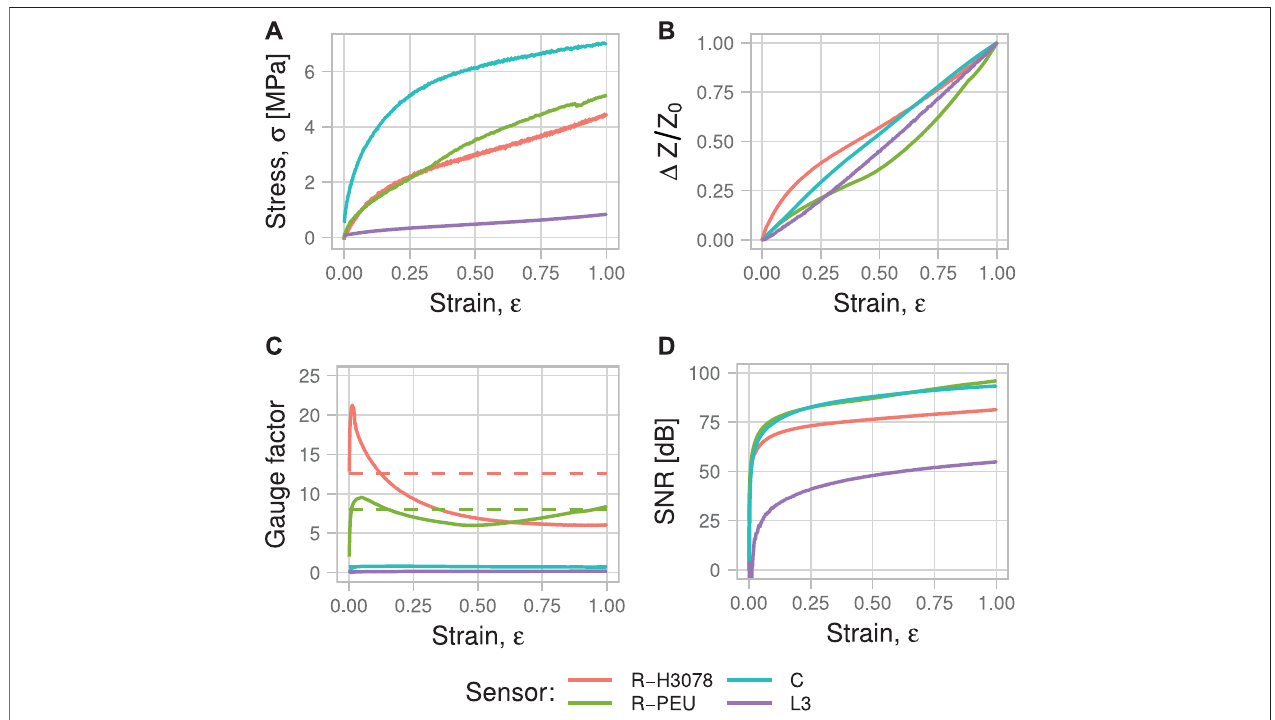
FIGURE 3 | (A) Mechanical stress-strain curves for each sensor, (B) sensor output signal during the elongation, (C) instantaneous (solid) and average (dashed) gauge factor, (D) signal-to-noise ratio.